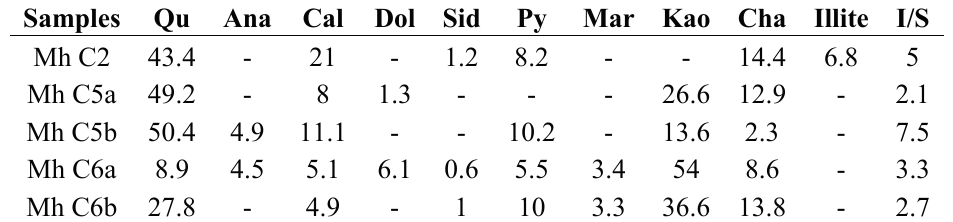
Table 2. Mineral compositions of low-temperature ashes (LTA) of the Mahe coals by XRD analysis and Siroquant (%; on organic matter-free